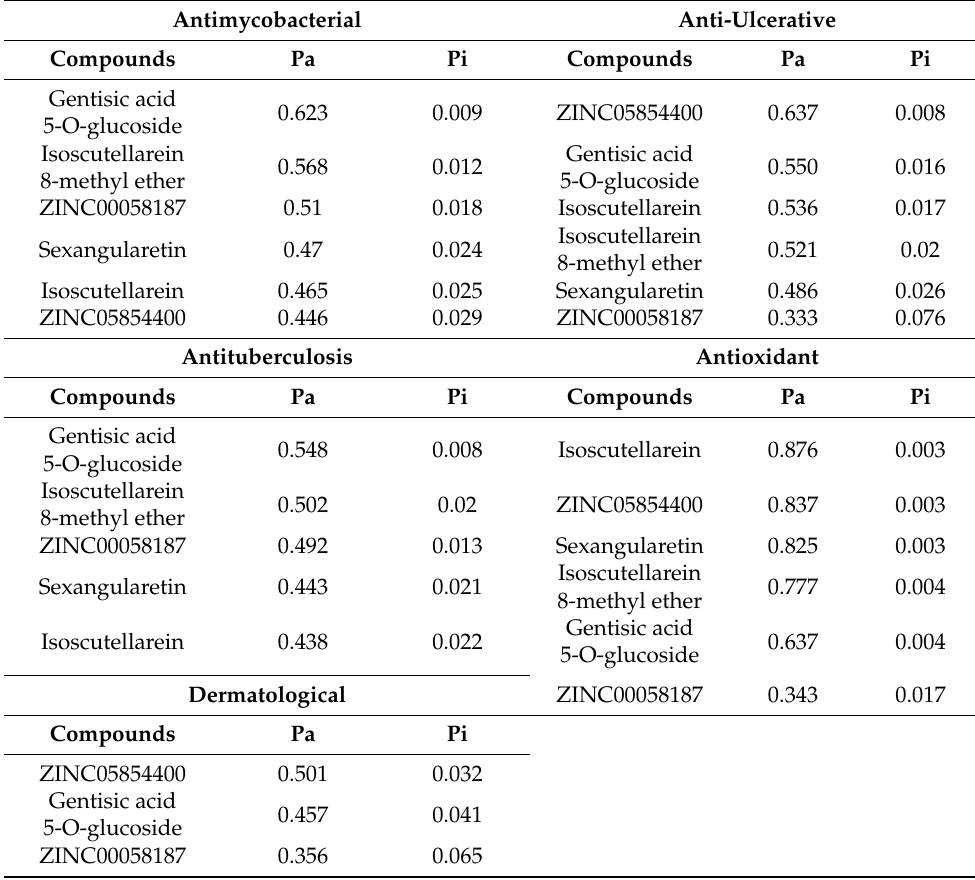
Table 5. Predicted biological activities of compounds with Pa > 0.3 and Pi< Pa. The biological activities comprise antimycobacterial, anti-ulcerative, antituberculosis, antioxidant and dermatological activity. Antimycobacterial Anti-Ulcerative